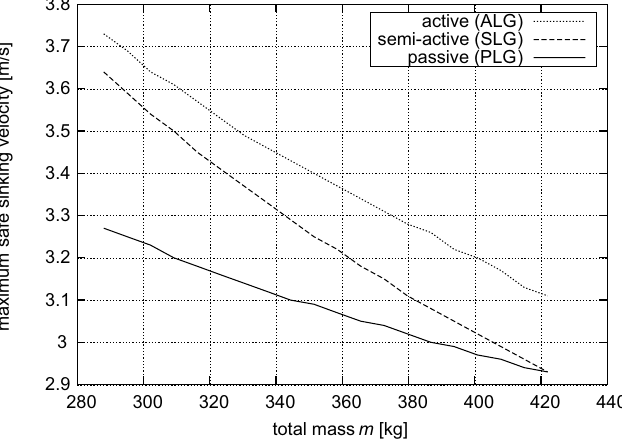
Fig. 16. Maximum safe sinking velocity at three control strategies in terms of the total landing mass.